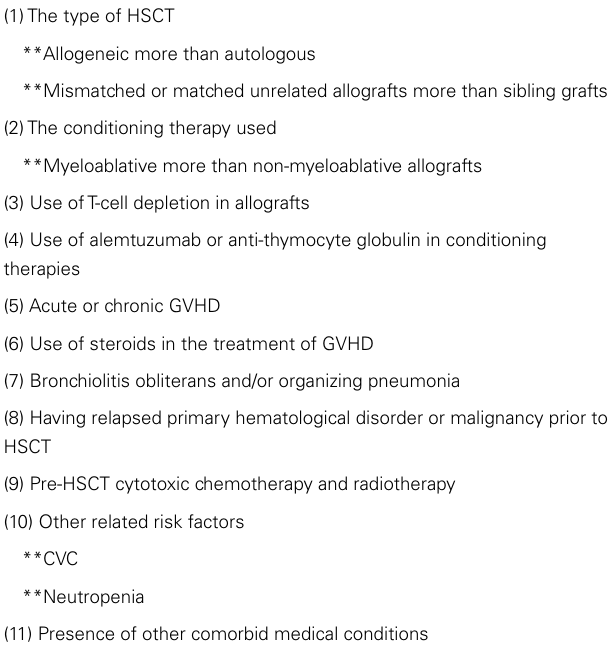
Table 6 | Shows risk factors for NTM infections in recipients of HSCT